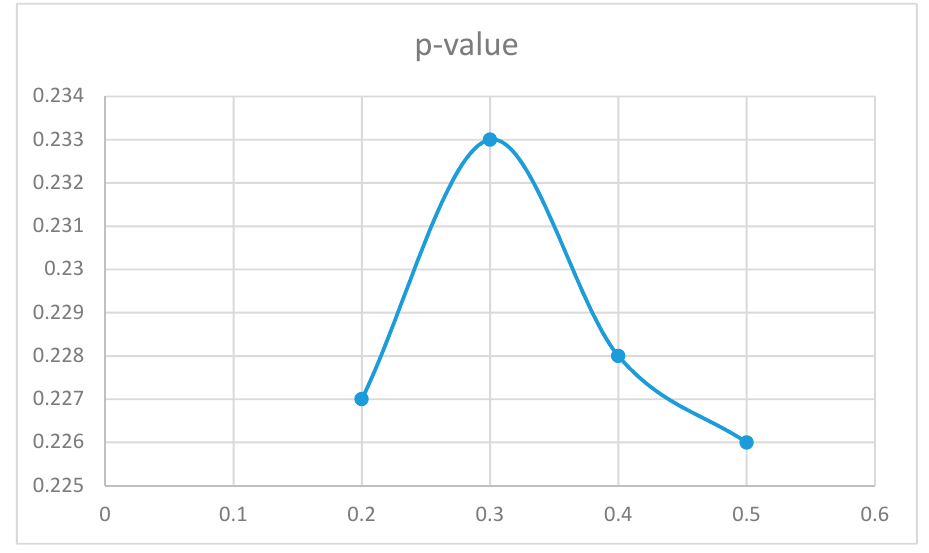
Figure 11. p-Values for different th values for the case of ADHD non-medicated participants with movements in the interval of 0.4 to 0.6 g.